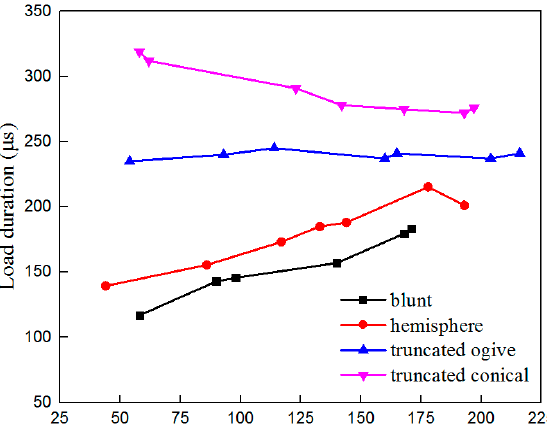
Figure 20. Pulse width of various nose-shape projectiles vs. impact velocity.